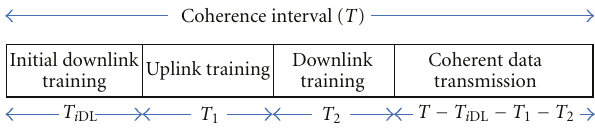
Figure 2: Transmission Phases for Informed